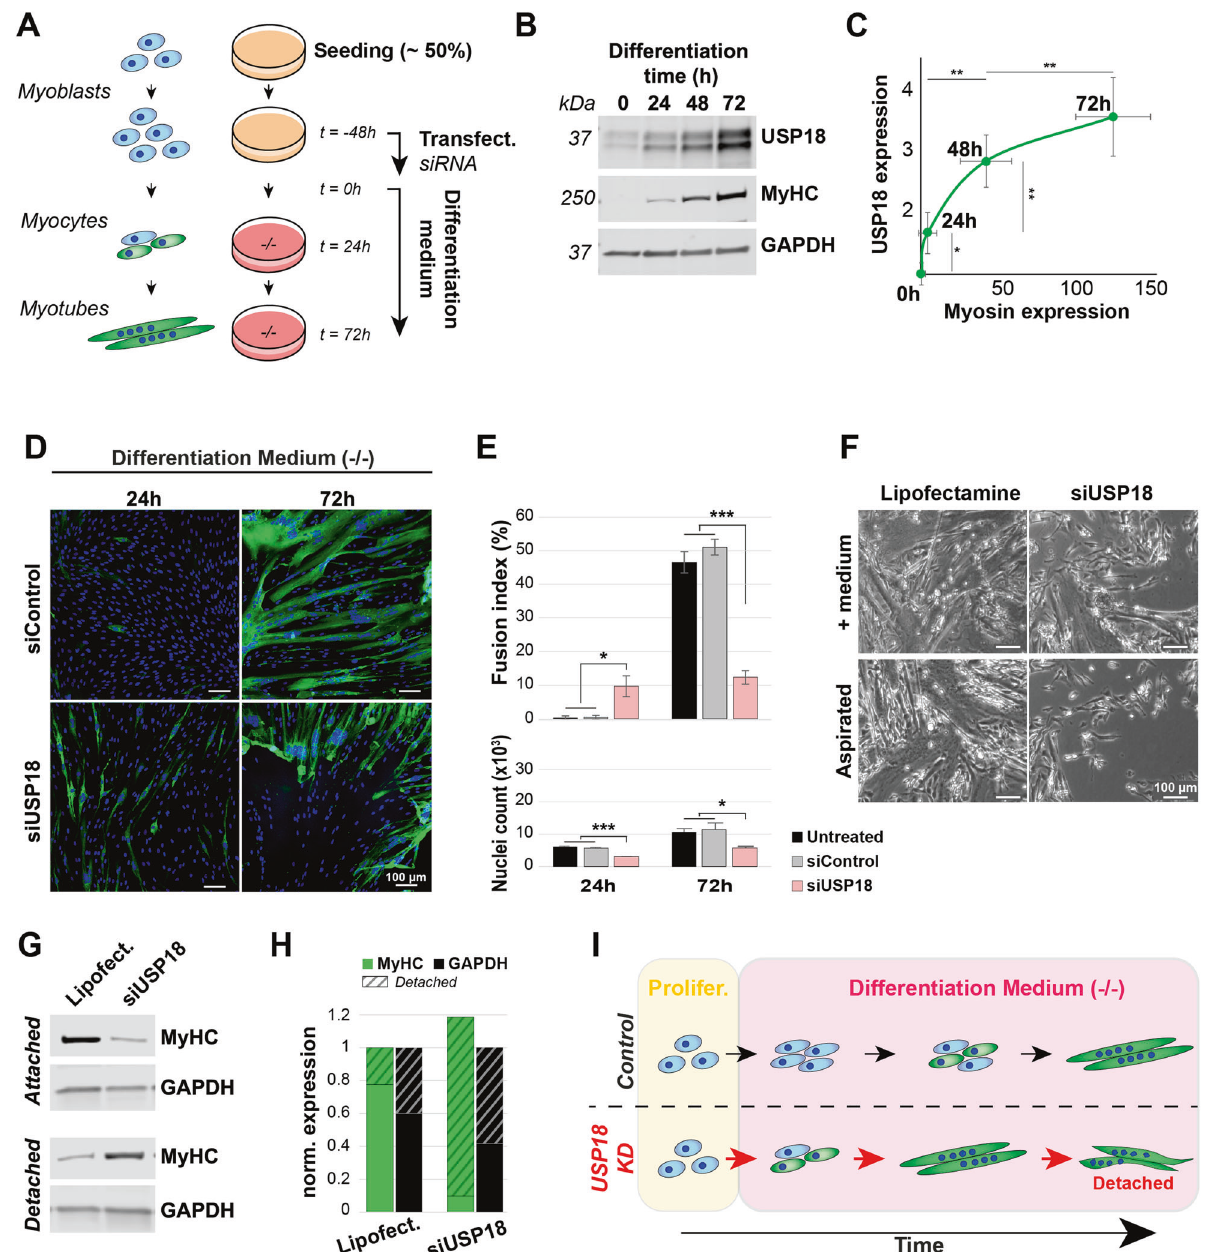
Fig. 2 USP18 knockdown (KD) accelerates differentiation in immortalized skeletal muscle cells. A A schematic overview of muscle cell differentiation and sequential USP18 KD experimental setup. Differentiation in the experiments in this fi gure were induced by medium starvation without the presence of horse serum, to prevent external factors from triggering USP18 expression. All experiments were performed in at least three biological replicates. B A representative western blot shows USP18 expression during human muscle cell differentiation marked by MyHC in immortalized cell cultures. GAPDH was used as loading control. C Scatter plot shows USP18 levels against MyHC levels normalized to GAPDH at 0 h, 24 h, 48 h and 72 h of differentiation. Average and error bars (standard deviation (SD)) are from four biological replicates. D Representative immuno fl uorescence images show MyHC (green) staining of cell transfected with siControl or siUSP18 cultured in differentiation medium for 24 h or 72 h. Nuclei are colored in blue. Scale bar is 100 μ m. E Bar charts show fusion index and cell number of untransfected, siControl or siUSP18 transfected cell cultures of panel D , in respectively black, gray or pink bars. Average and error bars (SD) are from 3 replicates. Statistical signi fi cance is depicted by asterisks. (*0.05 – 0.005 and ***< 0.0005). F Images taken with a bright fi eld microscopy show the differentiated cultures before collection for protein extraction. Scale bar is 100 μ m. G A western blot shows MyHC levels in attached cells after 72 h incubation and in the medium collected from the same cultures ( = detached) of muscle progenitors after USP18 KD. GAPDH of both fractions is used as loading control. H Bar chart shows MyHC (green) or GAPDH (black) expression. Attached fraction is in full color and detached in stripes. MyHC is normalized to the sum of GAPDH in detached and attached fraction. I Schematic summary of the accelerating effect of USP18 knockdown during starvation (no horse serum) induced differentiation.